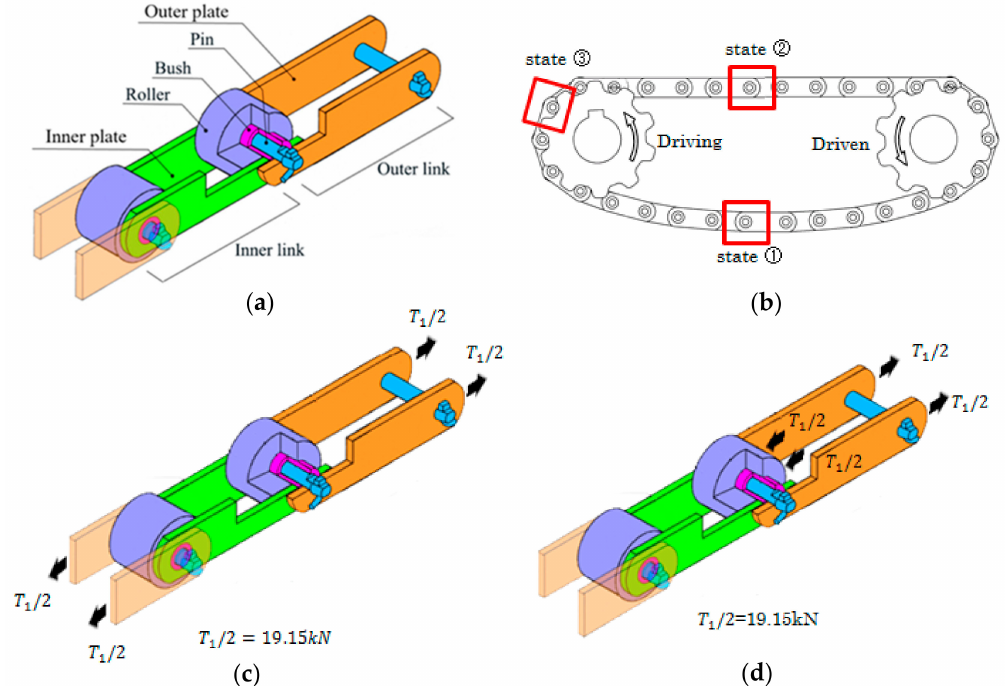
Figure 1. Schematic illustration of the roller chain: ( a ) press-fitting state (state 1 (cid:13) ). In this state, pin is fitted into outer plate. Bush is fitted into inner plate. Only roller can rotate; ( b ) roller chain drive system; ( c ) tensile state (state 2 (cid:13) ); ( d ) sprocket-engaging state (state 3 (cid:13)